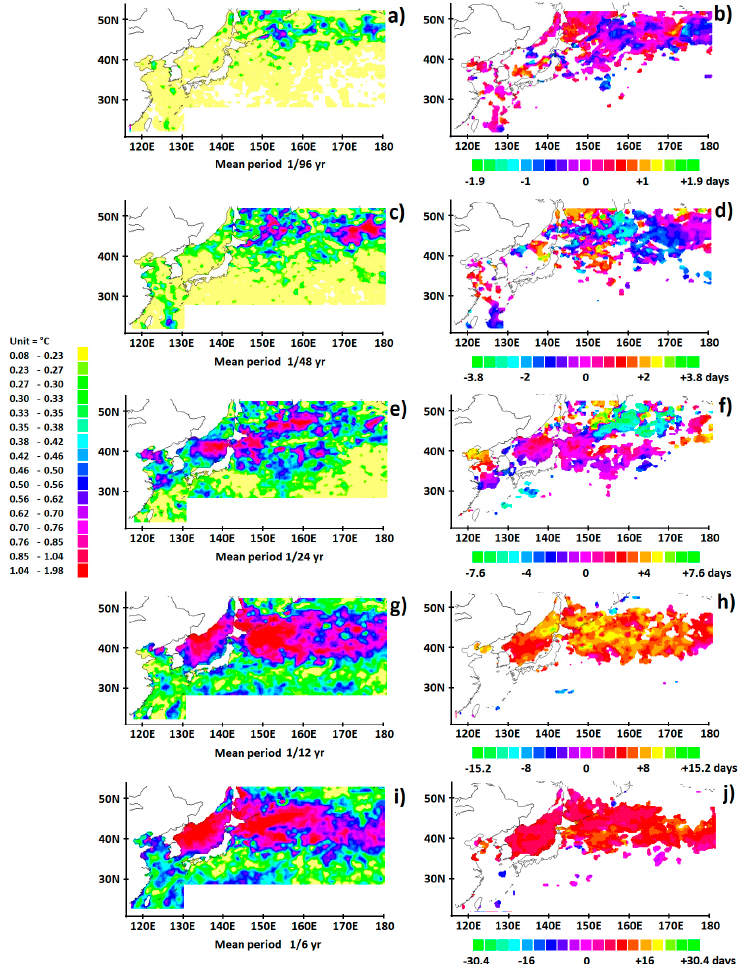
Figure 6. Same as Figure 3 for the amplitude ( a , c , e , g , i ) and the phase ( b , d , f , h , j ) of SST whose anomalies are positive when the time lag is zero. Same data sources as in previous figures. Compared to SSH, SST anomalies are translated to the north while widening (Figure 6). This translation that appears especially during the first 3 periods is of short duration, which suggests the role of the atmosphere. Highly contrasted during the first 3 periods, the phases of SST anomalies become uniform as the period increases. As shown in the Figure 6j, uniformity of the phase is achieved for the harmonic 1/6, which confirms that the lifetime of the SST anomaly is very short compared to the period close to 2 months. 3.2. The Marine Cold Wave that Accurred on 5 January 2020 Figure 7 shows the amplitude and the phase of SST anomalies during the cold event. Anomalies are little translated toward the north, which suggests the weakness of the SST response to the meridional component of the wind resulting from a high-pressure system initiated by the negative SST anomaly of the gyre. Here again, the phase shows a mosaic of convergent and divergent cells characterized by the inversion of geostrophic currents (Figure 7d,f). But contrary to what happens for MHWs, the phase does not homogenize when the period increases, reflecting the SSH anomaly. This suggests the weakness of the ocean–atmosphere interactions, hence the weak climatic impact of marine cold waves.